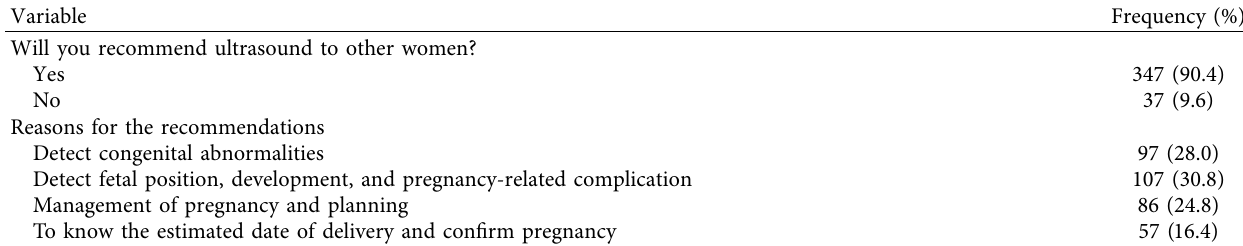
Figure 3: Knowledge of congenital abnormalities that ultrasound can diagnose. Table 5: The women’s reasons for recommending ultrasound scanning to other